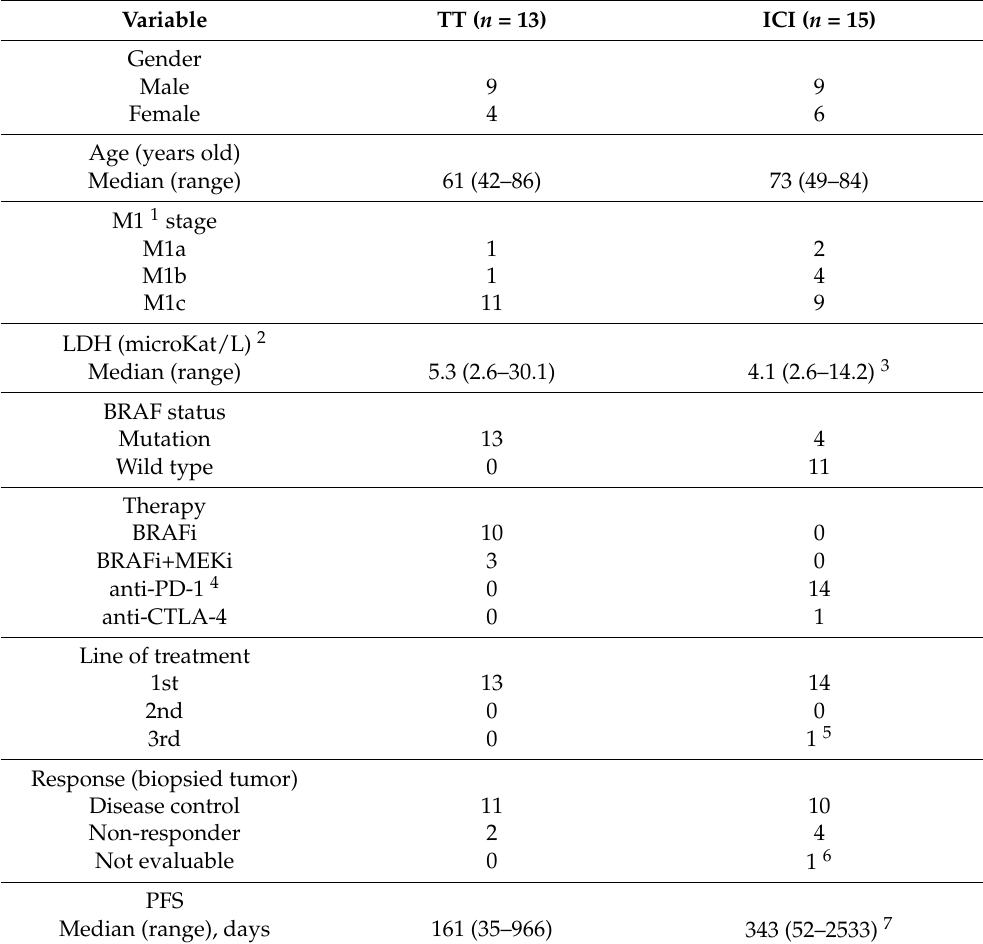
Table 1. Baseline clinical characteristics of patients receiving targeted therapy (TT) or immune checkpoint inhibitor